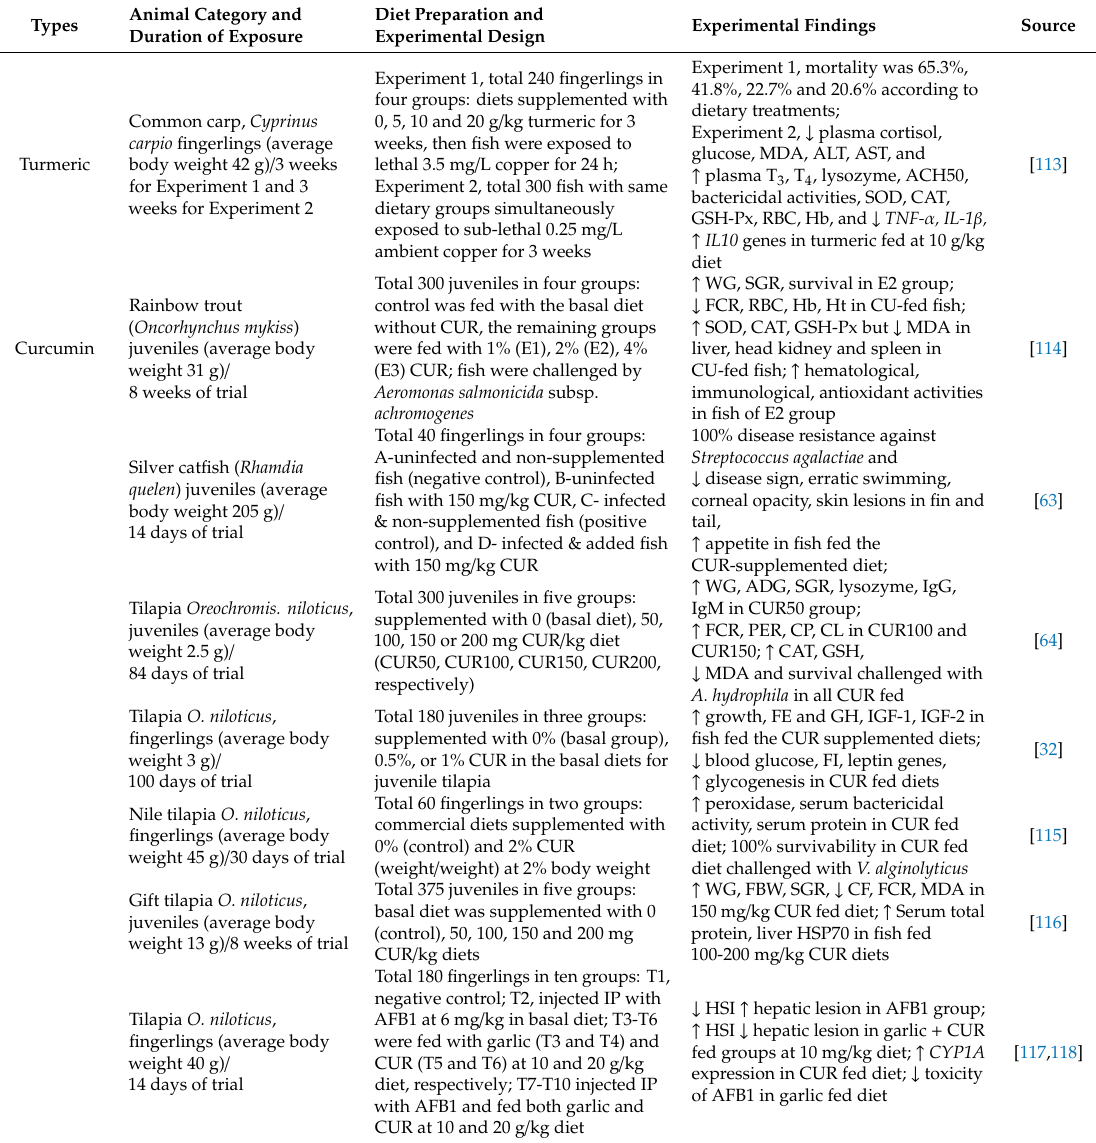
Table 4. E ff ects of dietary turmeric and curcumin in fish